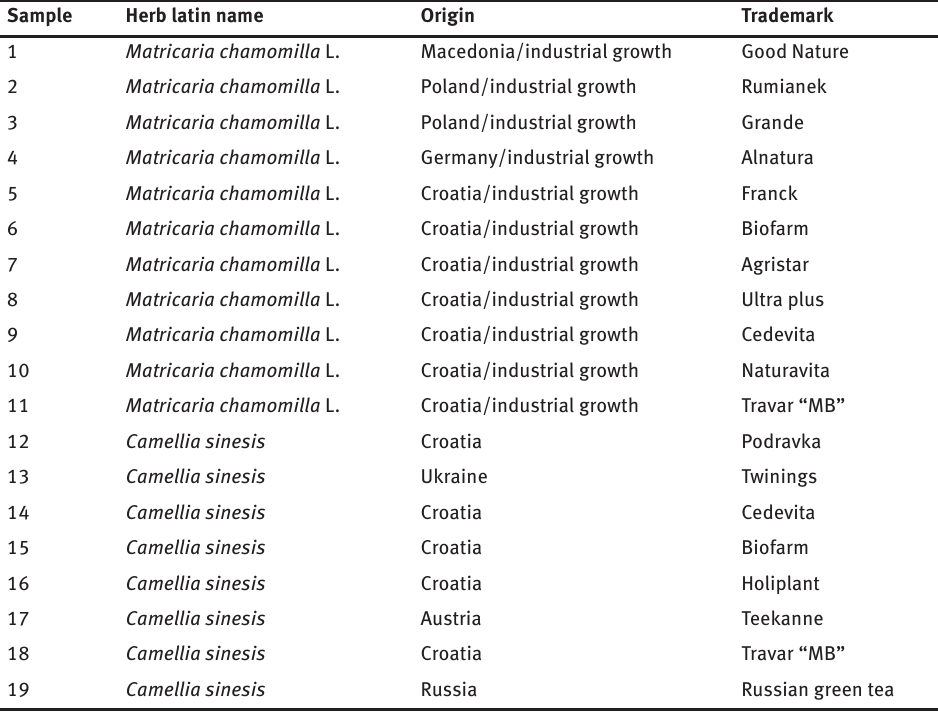
Table 3: Information of investigated herbal tea